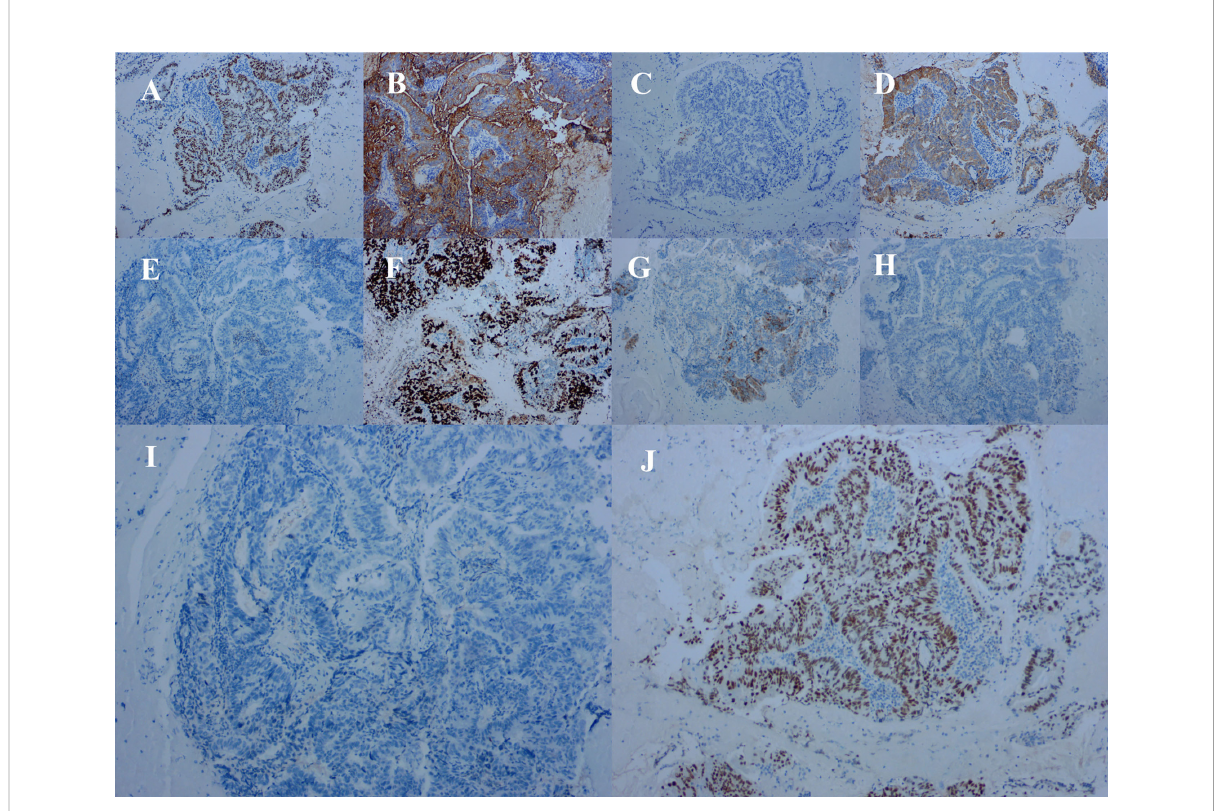
FIGURE 4 Immunohistochemical staining of tumor cells for (A) caudal-related homeobox 2 (positive), (B) carcinoembryonic antigen